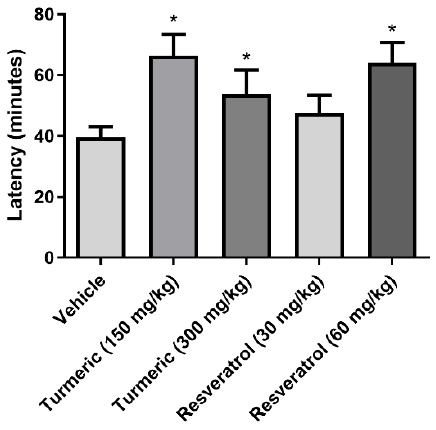
Figure 2. SE latency after pilocarpine injection. The 150 and 300 mg/kg of turmeric and 60 mg/kg of resveratrol groups prolonged SE latency compared to the vehicle group. Data were analyzed by one-way ANOVA, followed by Tukey’s multiple comparison test. Data are expressed as the mean ± standard error. * p < 0.05 vs. the vehicle group.